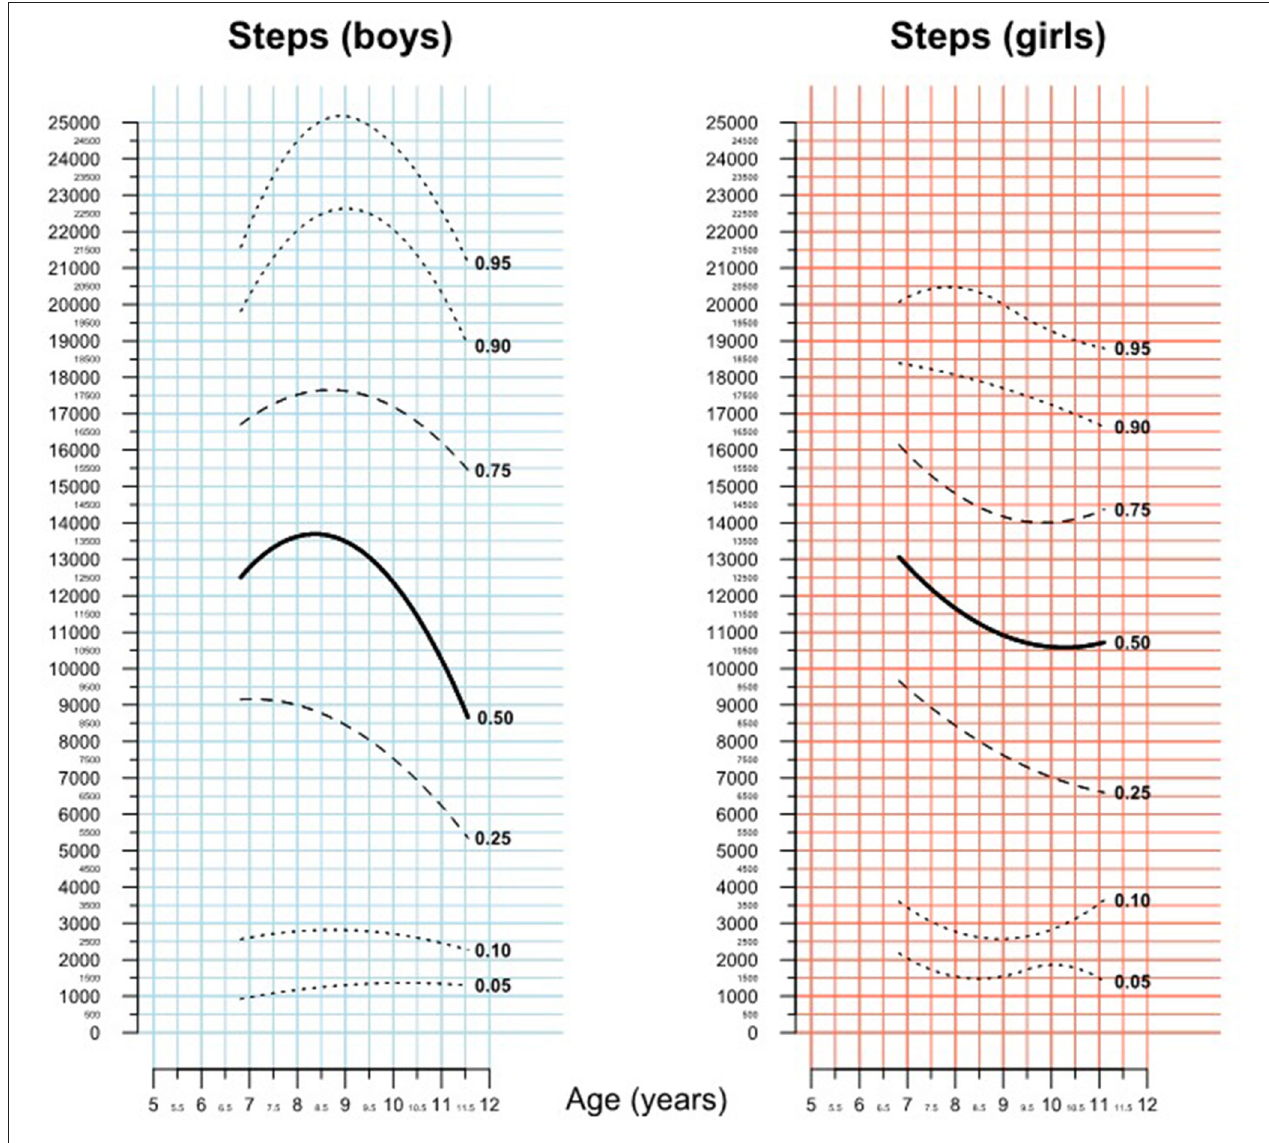
FIGURE 3 | Percentiles of total daily